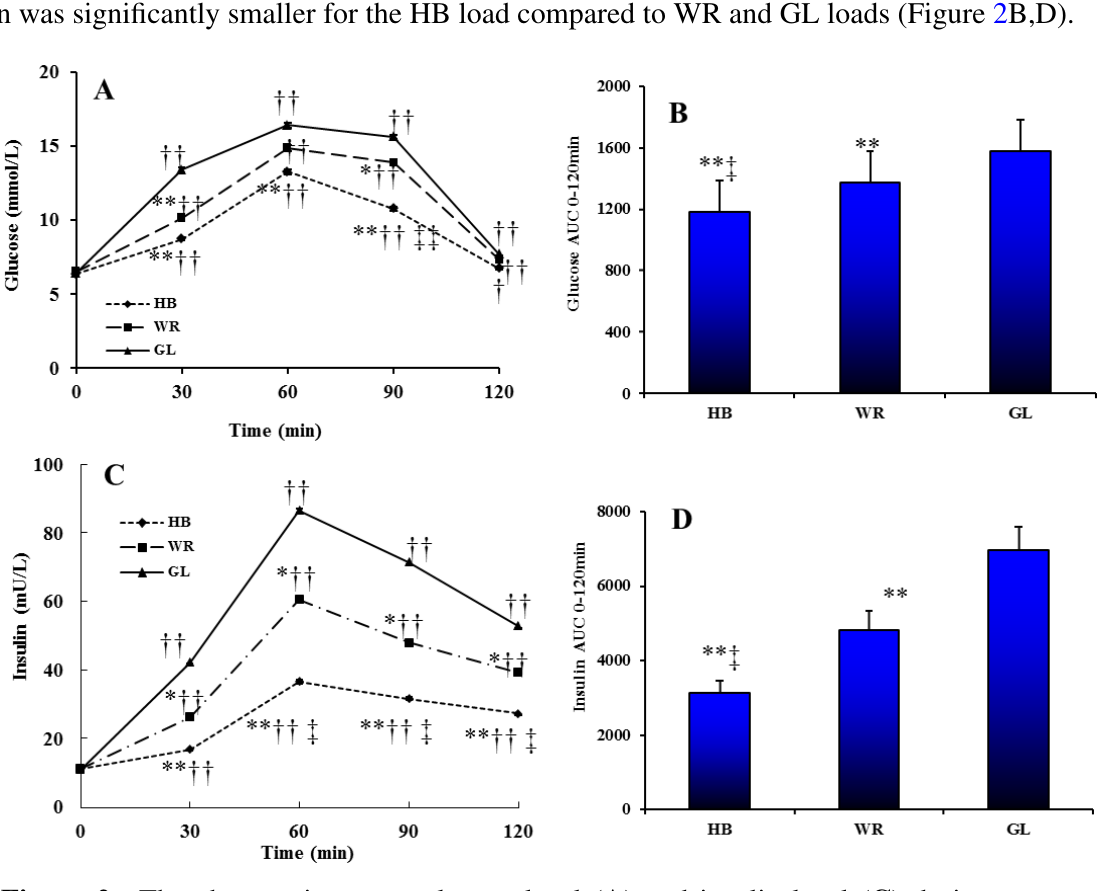
Figure 2. The changes in serum glucose level ( A ) and insulin level ( C ) during tree test loads.